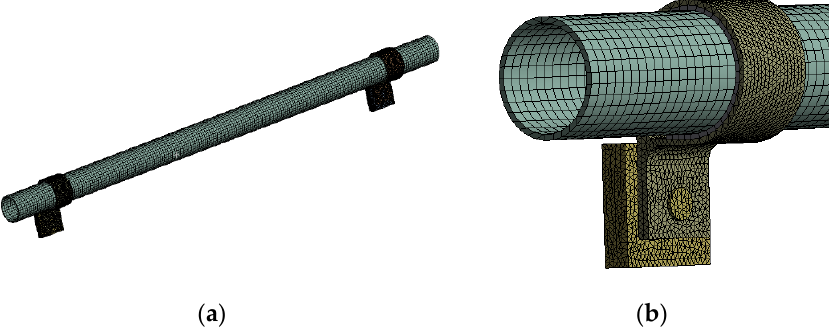
Figure 4. Aviation hydraulic clamp-pipeline meshing diagram. ( a ) Clamp-pipeline model grid division diagram; ( b ) Partial diagram of clamp grid division.